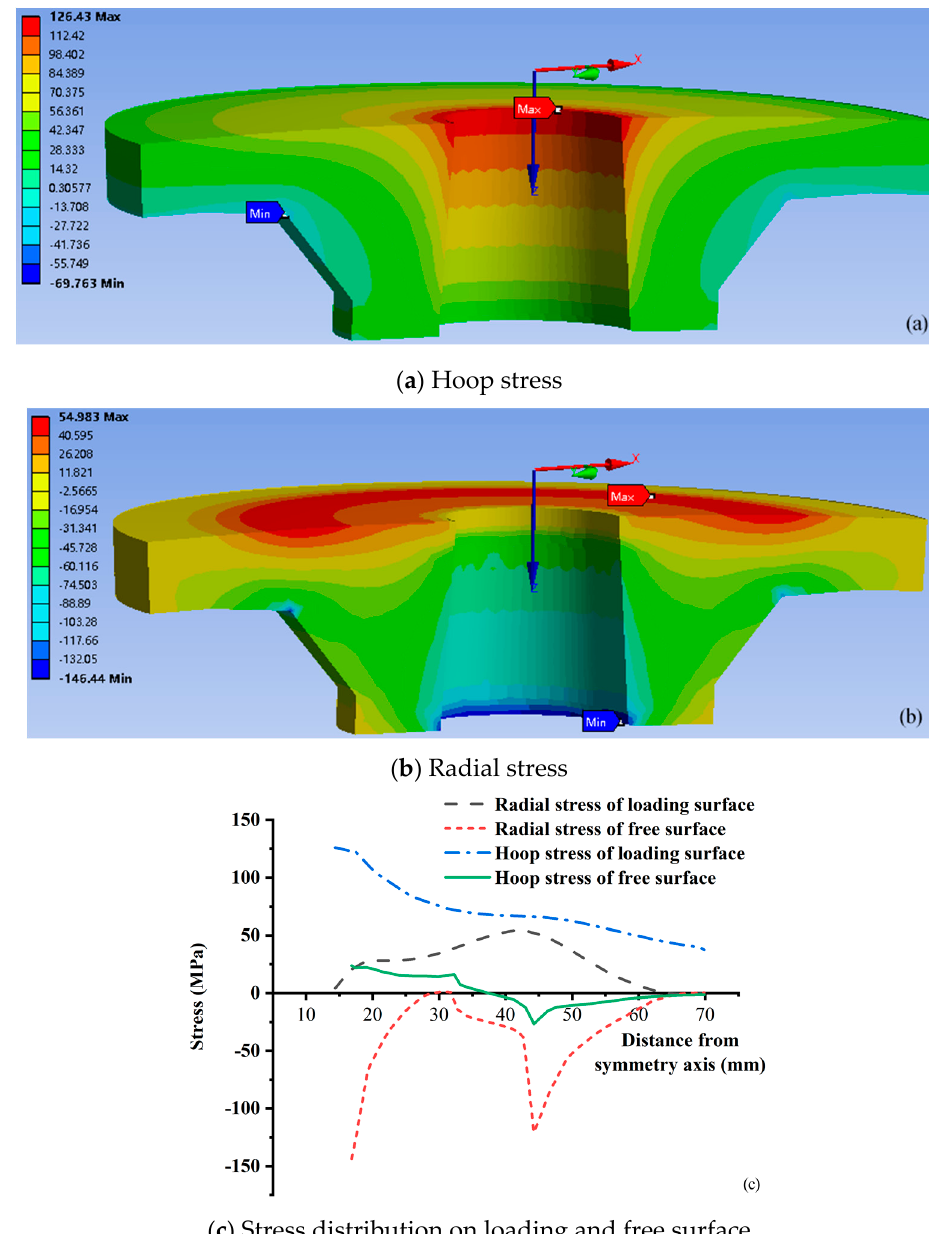
Figure 15. Numerical simulation stress distribution of the